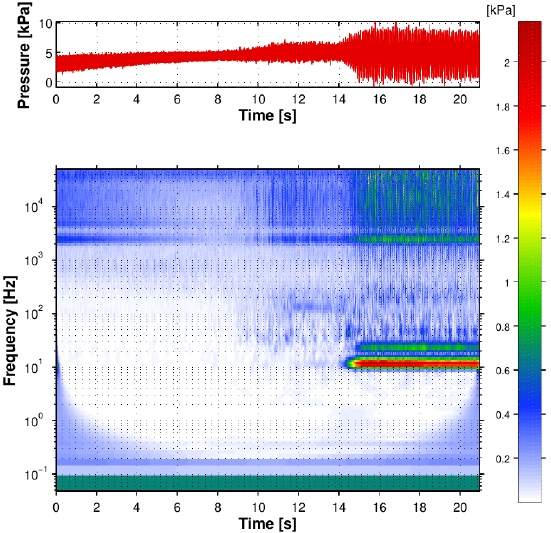
Figure 10: Pressure signal at gauge p imp 3 and its CWT